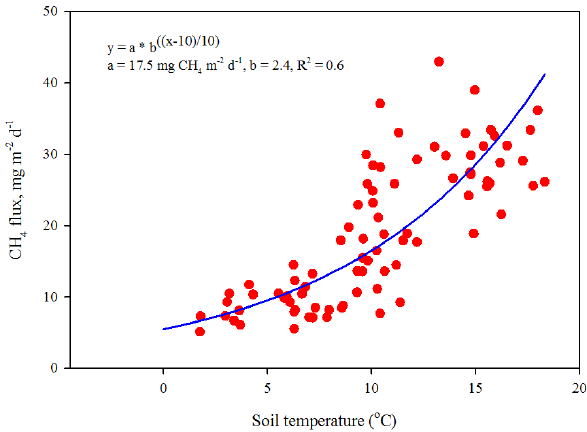
Figure 5. Dependence of CH 4 flux measured using EC technique from June until early October at fen surfaces on soil temperature. The solid line represents the Q 10 function fitted to the data using a nonlinear least-squares fit ( x is soil temperature, y is daily mean methane flux, a represents the base methane flux rate and b is the Q 10 coefficient). The statistics generated from the regression anal- ysis are also presented in the